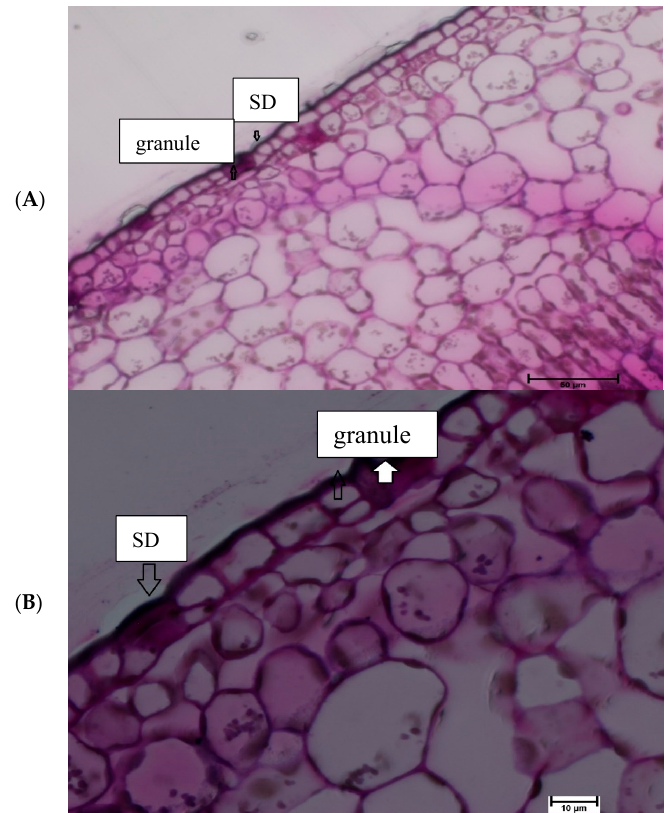
Figure 6. Si treated matured citrus leaves subjected to light microscopy lower epidermis surface at ( A ) 40 × , and ( B ) 100 × magnification: Arrows in the diagram represent silica granules in the epidermal surface and Si deposit in outer cell regions constitute the cuticle silica double layer